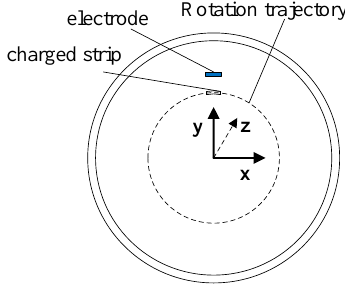
Figure 7. Simplified schematic.